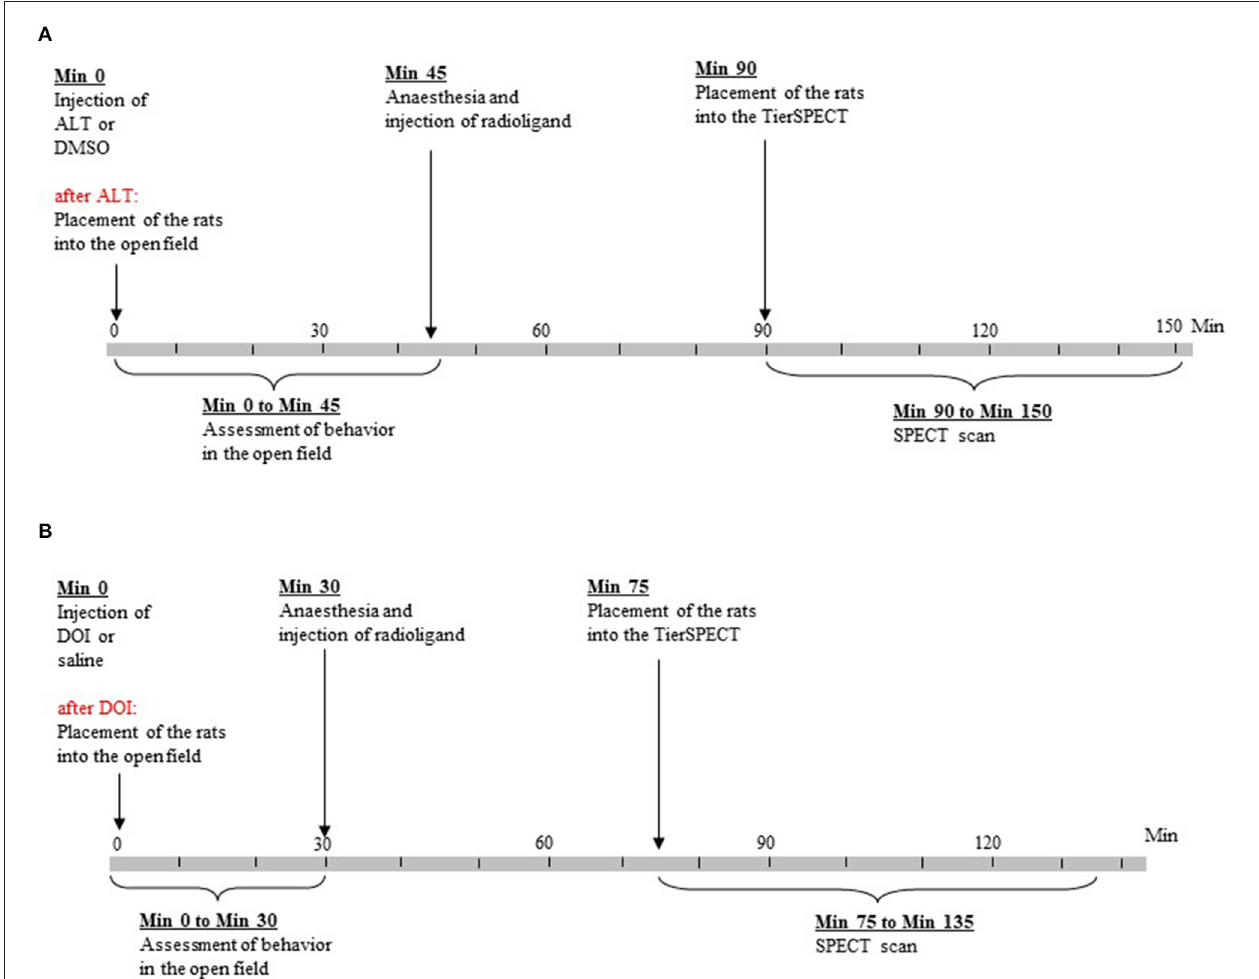
FIGURE 1 | Time lines of experimental procedures. (A) Treatment with altanserin (ALT) and dimethyl sulfoxide (DMSO). (B) Treatment with 2,5-dimethoxy-4- iodoamphetamine (DOI) and saline.